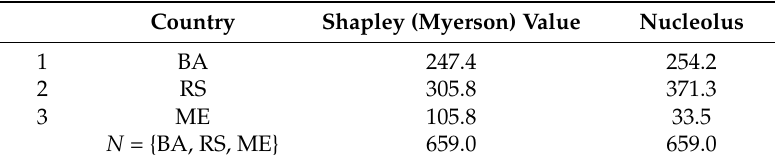
Table 3. Solutions for the 3-country game (in